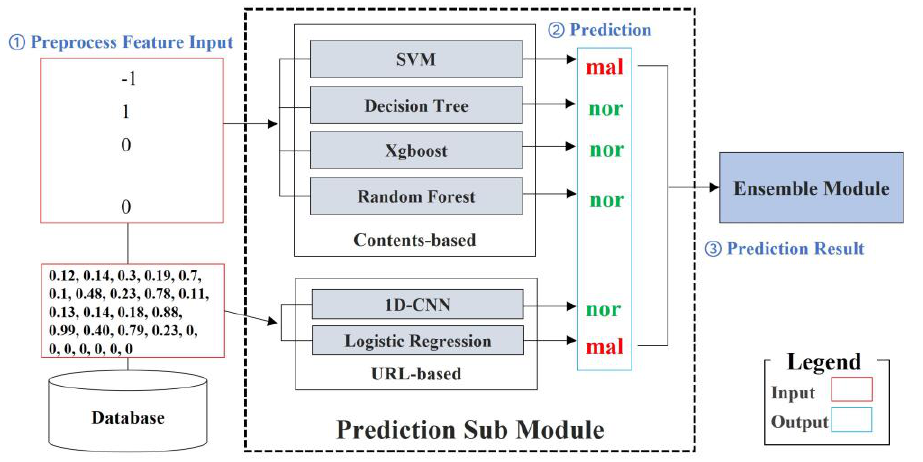
Figure 4. Sub − model Prediction.